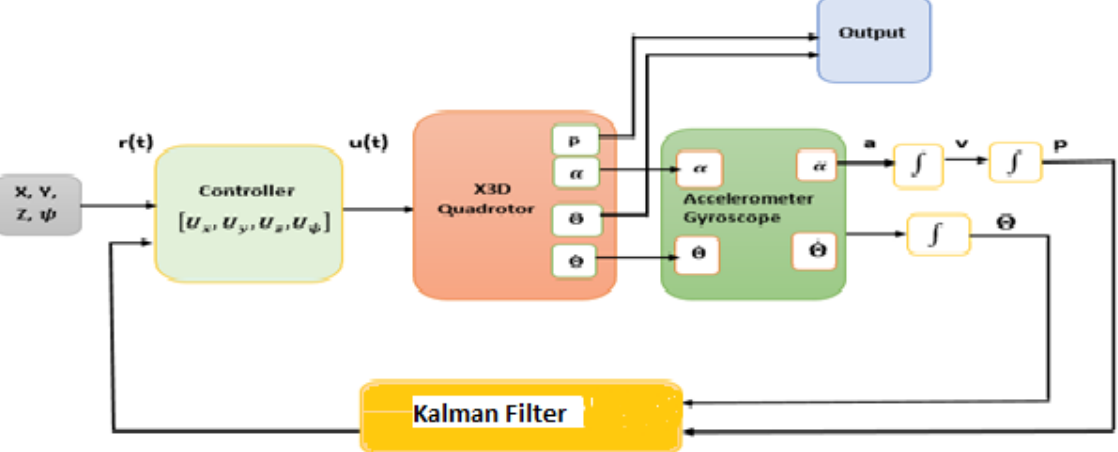
Figure 12. Quadrotor closed-loop control system.